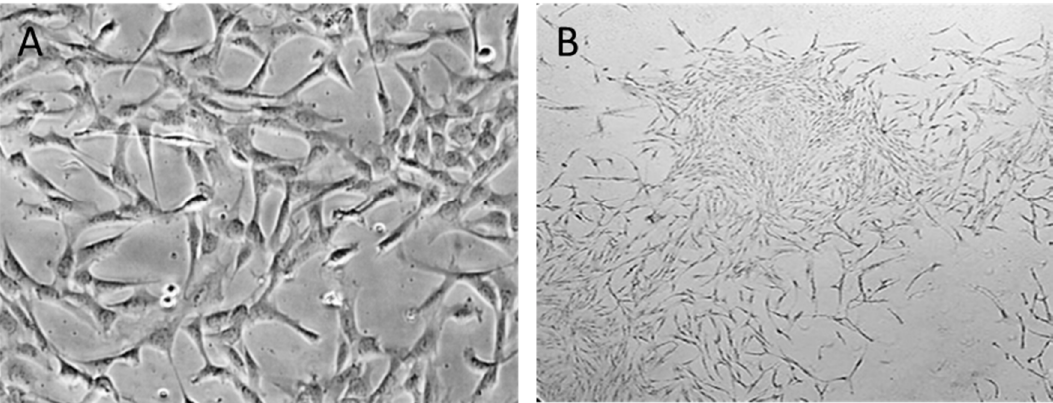
Figure 1. Morphology of ASCs. ( A ) Isolated ASCs are typically expanded in monolayer (2D) culture plastic (original 20× magnification) and ( B ) ASCs colony-forming potential (original 4×